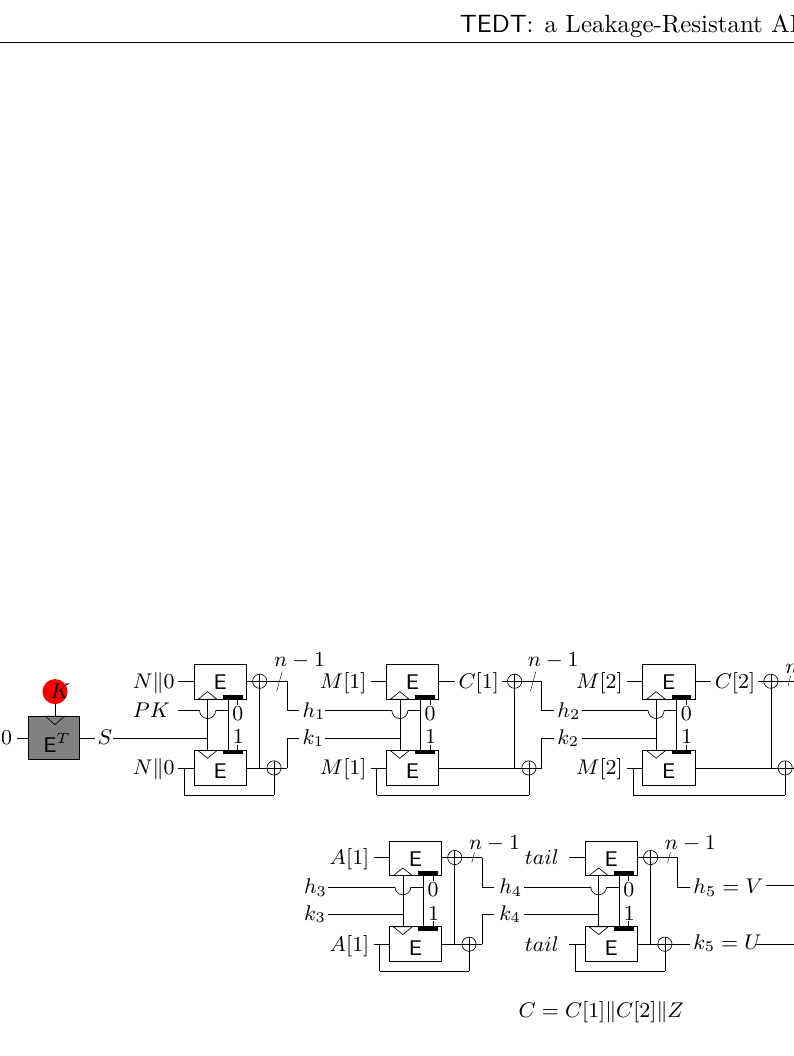
k [ | A | ] , and T = PK k n/ 2 n/ 2